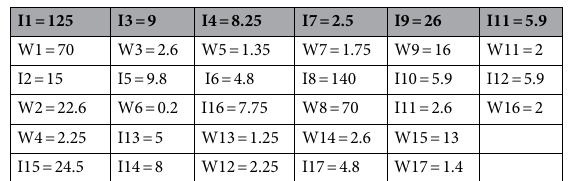
Table 2. Comprehensive measurement of projected MIMO antenna (units in mm).